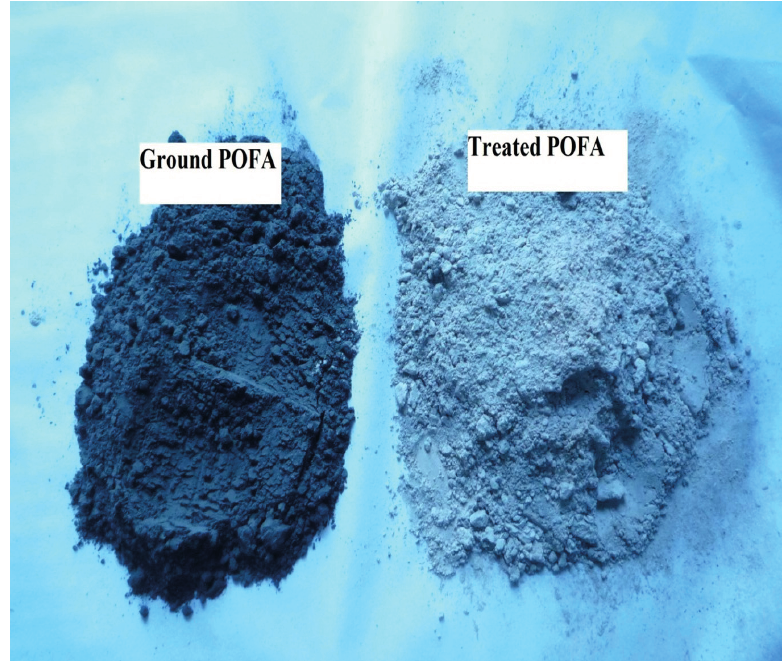
Figure 1. Difference in colour for ground POFA and treated